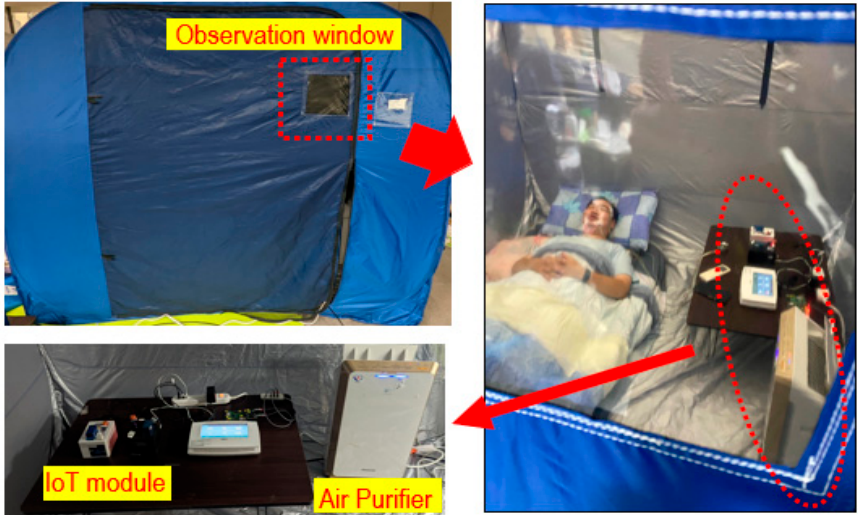
Figure 3. Clockwise from top left, shown are the outlook of the jump-up CUSP (CAQLEA) system, setup of the experiment seen through the observation window, and the equipment for all-night sleep